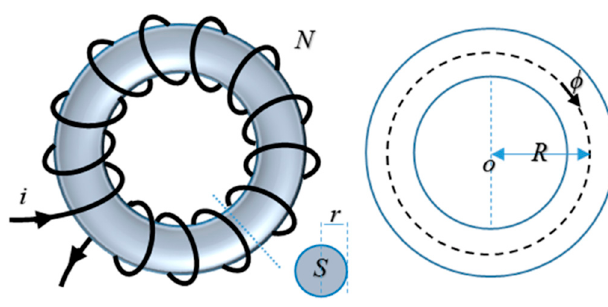
Figure 10. Inductor dimension.